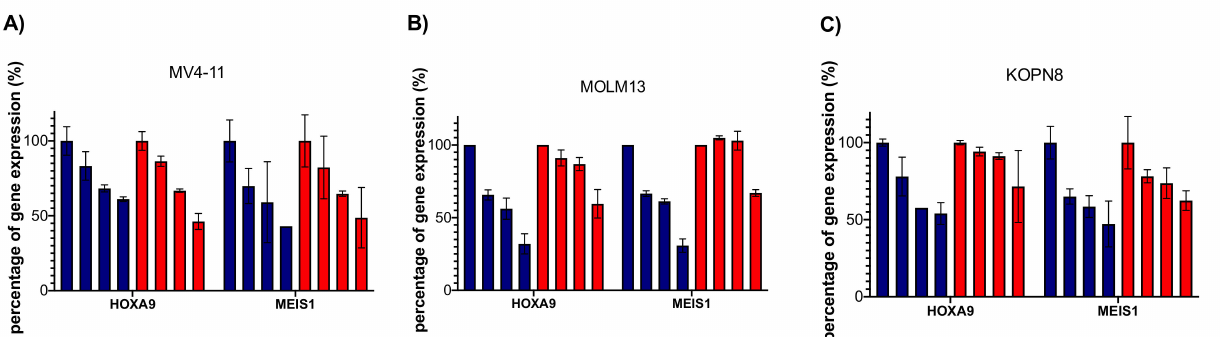
Figure 8. Expression variation of HOXA9 and MEIS1 genes in MV4-11 cells ( A ), MOLM-13 ( B ), and KOPN8 ( C ) treated for 6 days and 10 days, respectively, in the presence of Dia2 (in red) or EPZ-5676 (in blue) at the indicated concentration. The expression of each gene is quantified by RT qPCR relative to the B2M reference gene for HOXA9 and YWAX for MEIS-1. Data points result in mean normalized values issued from technical triplicates and biological duplicates.